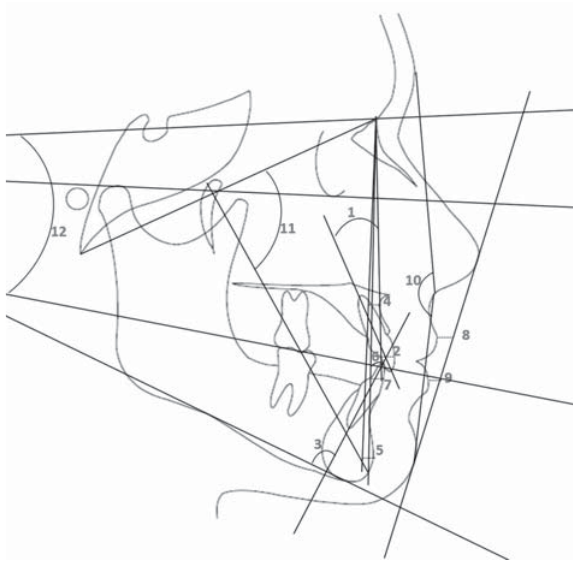
Figure 2- Cephalometric variables: 1, 1.Na; 2, 1-NA; 3, IMPA; 4, A-Nperp; 5, Pog-Nperp; 6, 1.NB; 7, 1-NB; 8, UL-E; 9, LL-E; 10, STC; 11, BaN/PtGn; 12, SN/Occlusal